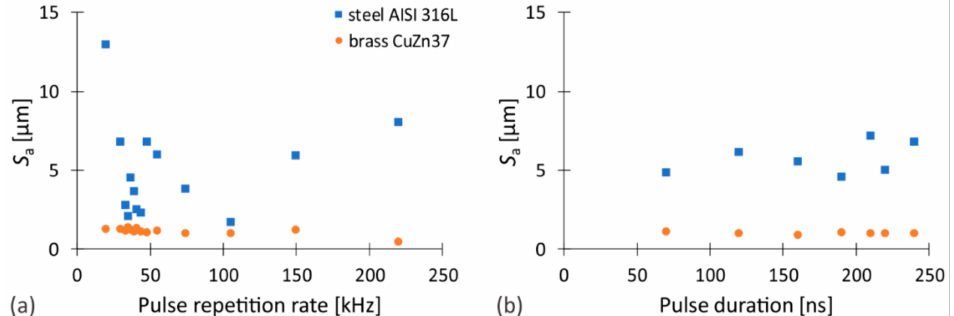
Figure 8. The evolution of the surface roughness as a function of ( a ) the pulse repetition rate and ( b ) the pulse